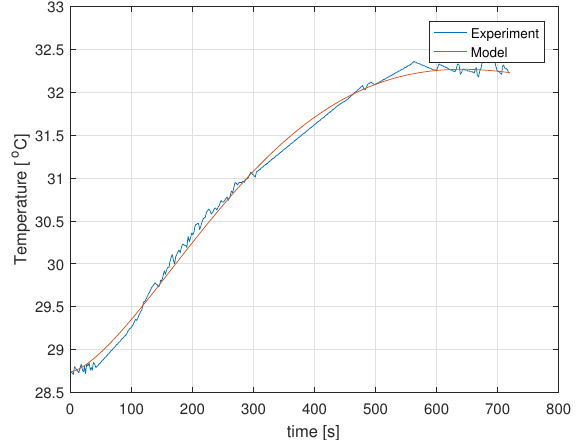
Figure 7. The step responses of the FO model and real plant for area